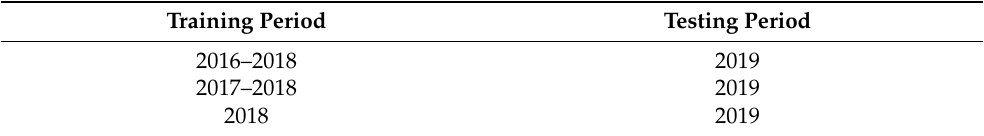
Table 11. Training and testing periods for comparison.